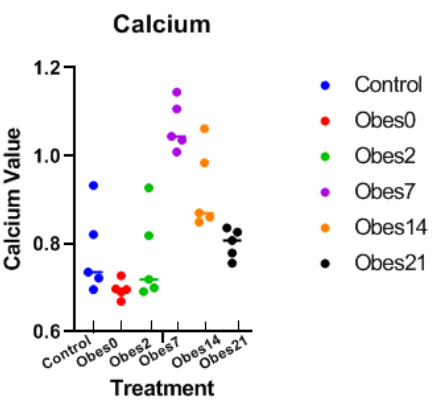
Figure 5. Calculation results for calcium levels. Calcium levels in μ g.